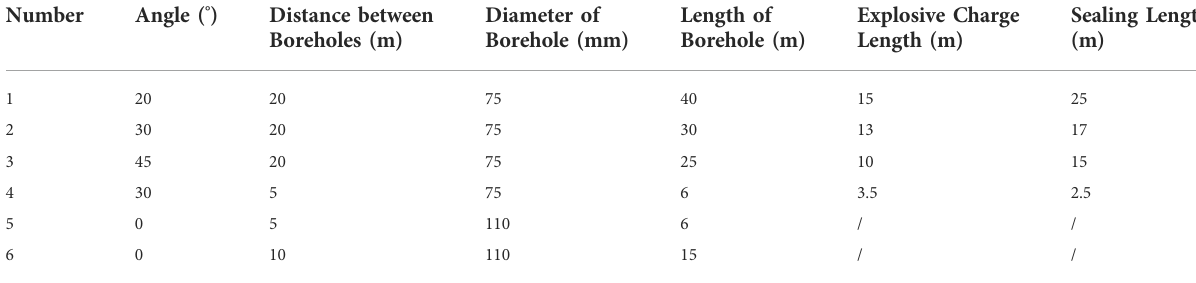
TABLE 4 Design parameters for boreholes 1# — 6# (see Figure